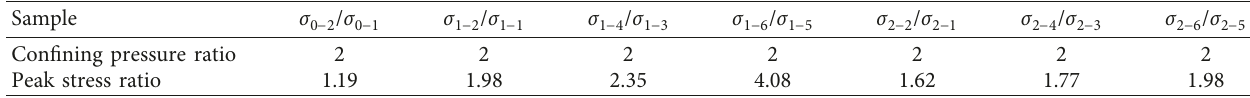
Table 4: Peak stress ratio of the filled cracked rocks.